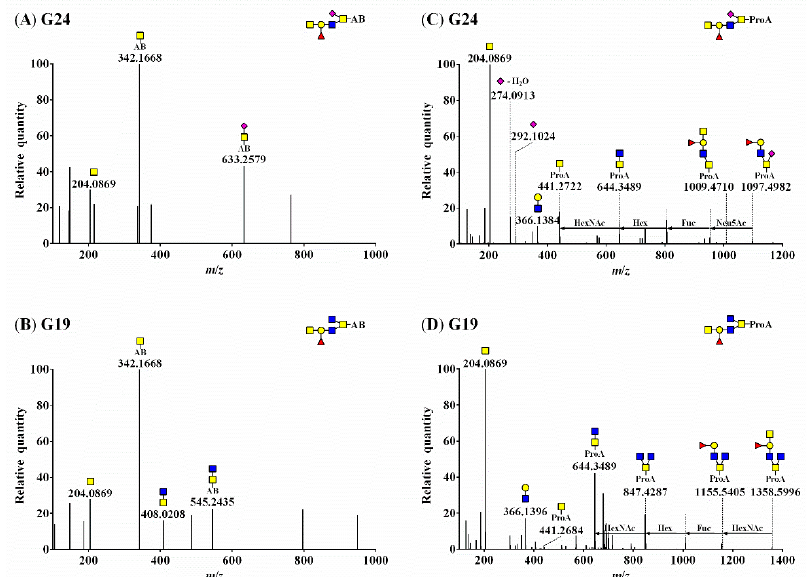
Figure 2. HCD–MS / MS spectra of AB-labeled O -glycans ( A ) G24 (theoretical m / z = 1347.5309) and ( B ) G19 (theoretical m / z = 1259.5148) and ProA-labeled O -glycans ( C ) G24 (theoretical m / z = 1446.6357) and ( D ) G19 (theoretical m / z = 1358.6196). (cid:4) , GlcNAc; (cid:4) , GalNAc; • , Gal; (cid:78) , Fuc; (cid:95) , Neu5Ac; ♦ , Neu5Gc.